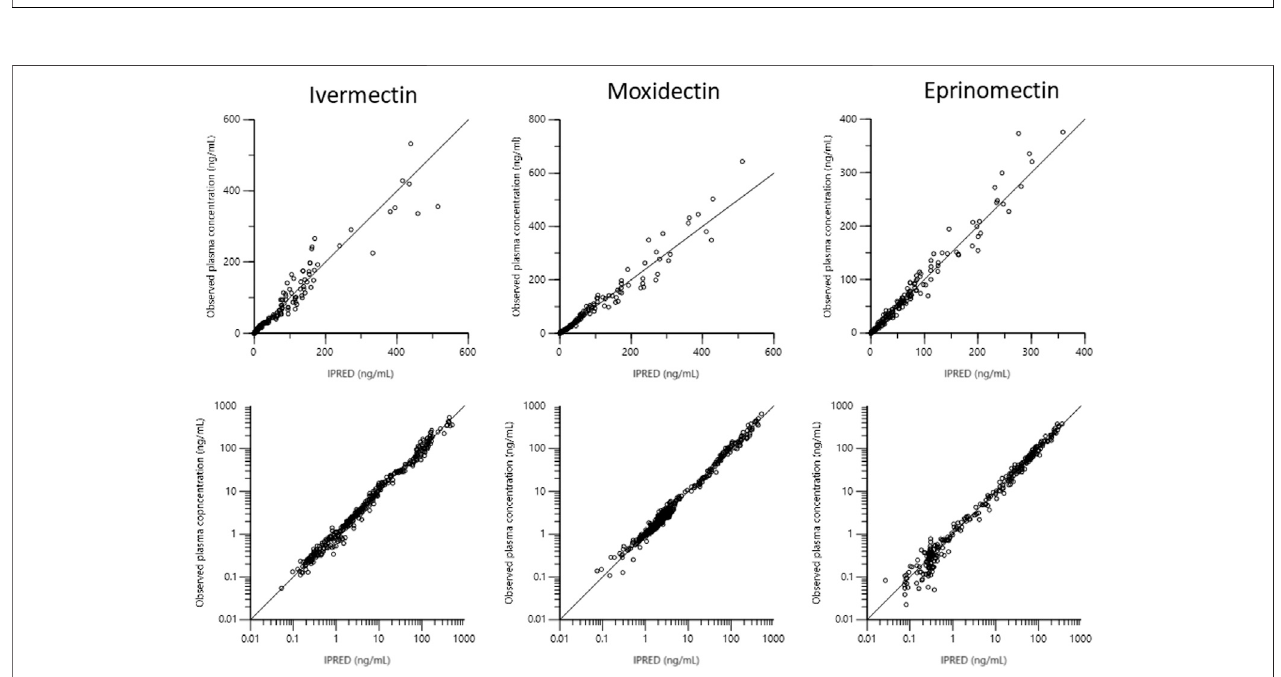
FIGURE 5 | Plots of the dependent variable, observed plasma concentrations (ng/mL), vs. individual predicted plasma concentrations (IPRED) for the three drugs. Individual predictions were obtained by setting random effects to the “ post hoc ” or Empirical Bayesian Estimate of the random effects for the individual dog, from which theplasmaconcentrationobservationwasmade.Thus,theplotillustratesobservedvs. fi ttedvaluesofthemodelfunction.Ideally,theyshouldfallclosetothelineofunity y (cid:1) x . Arithmetic scale (upper) and logarithmic scale (lower) .